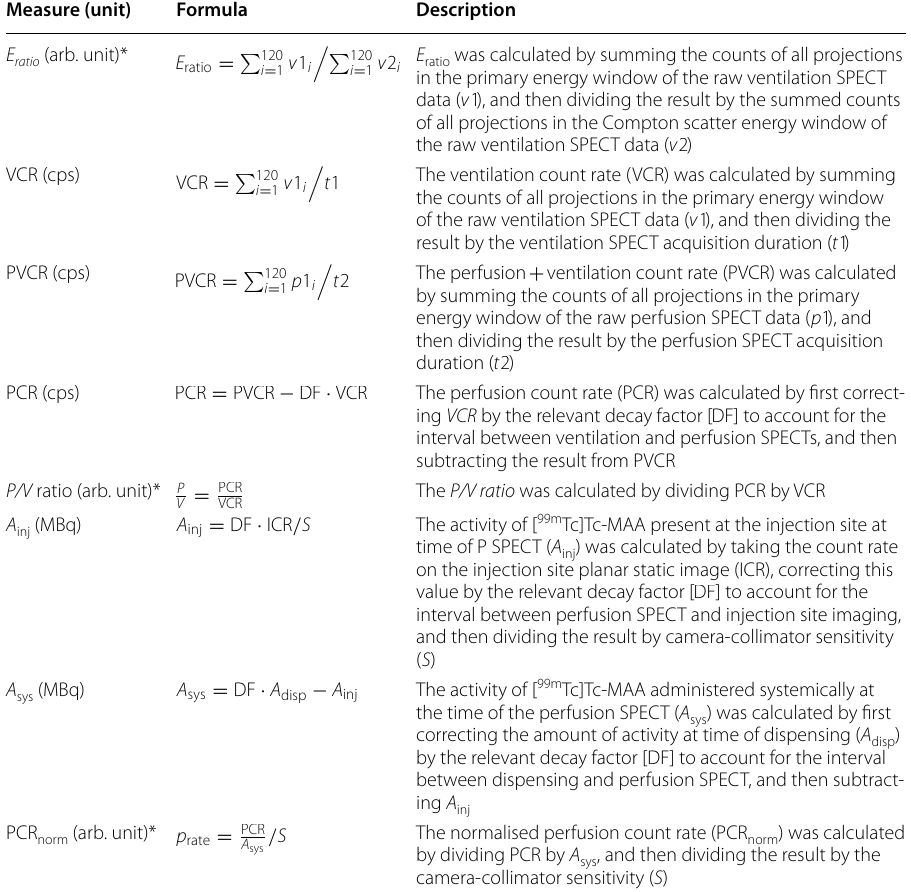
Table 2 Derived image